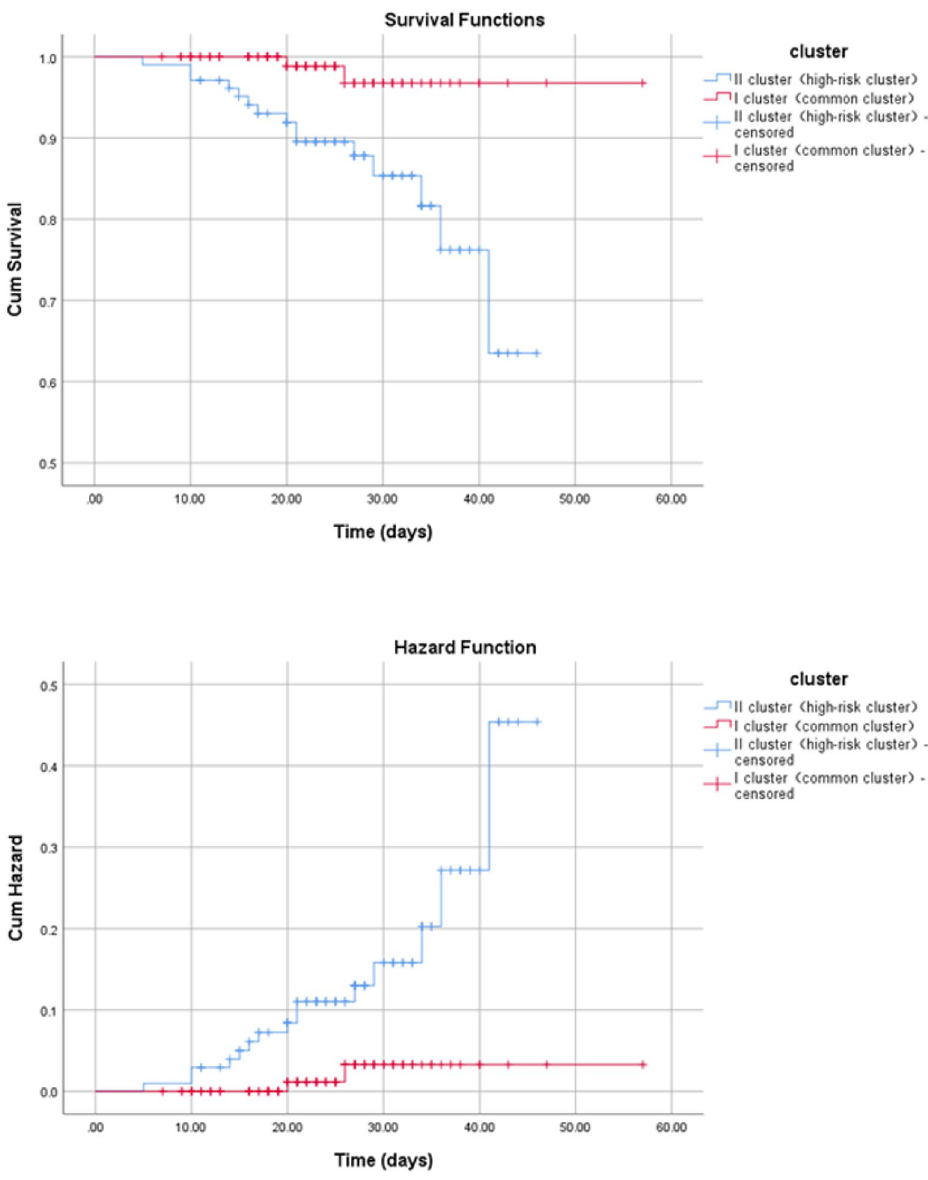
Figure 2. Kaplan–Meier survival curve analysis for two types of COVID-19